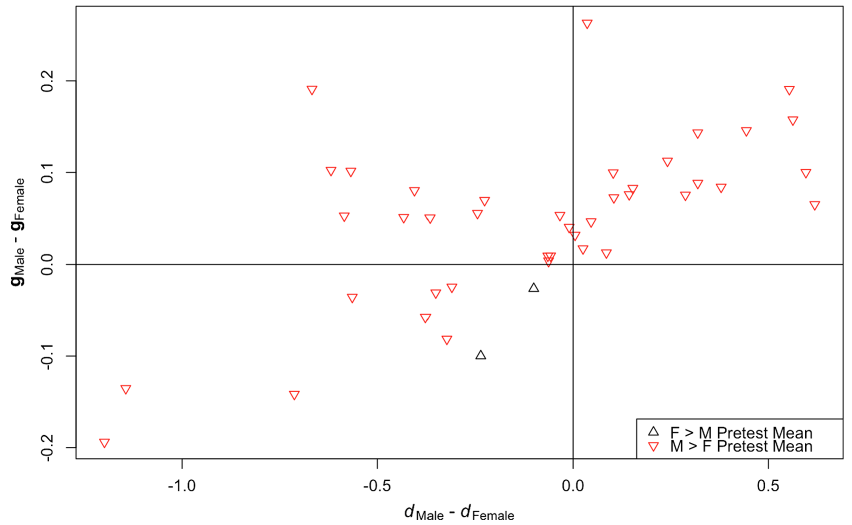
FIG. 3. Comparison of gender differences for d and g